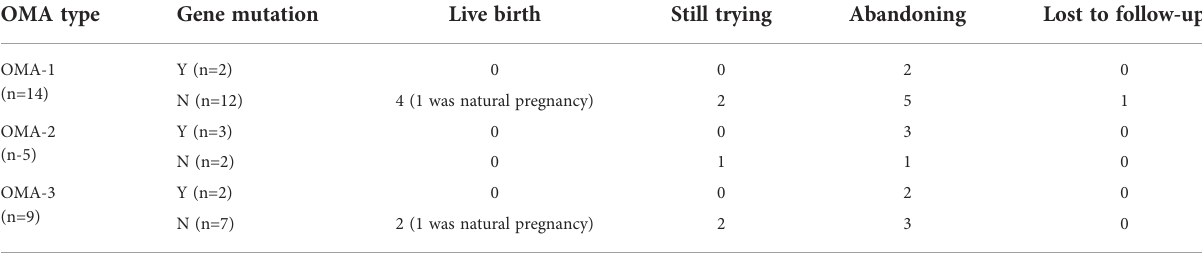
TABLE 3 Clinical outcomes of the OMA